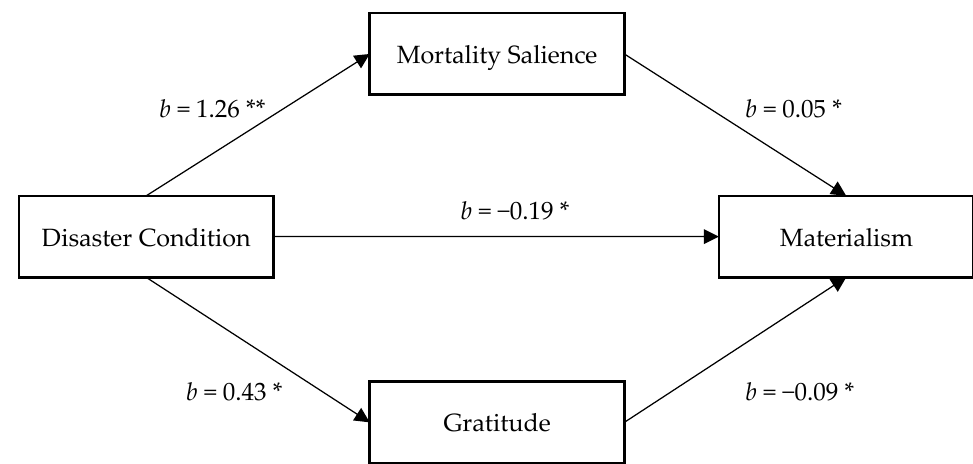
Figure 3. Mortality salience and gratitude as mediator of the relationship between condition and materialism. Note. Reported are unstandardized regression coefficients and standardized indirect effect with bootstrapped 95% confidence interval, ** p < 0.001, * p < 0.05.